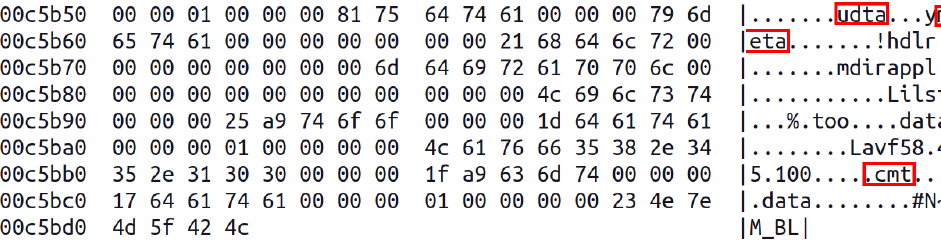
Figure 11. Result of embedding secret in